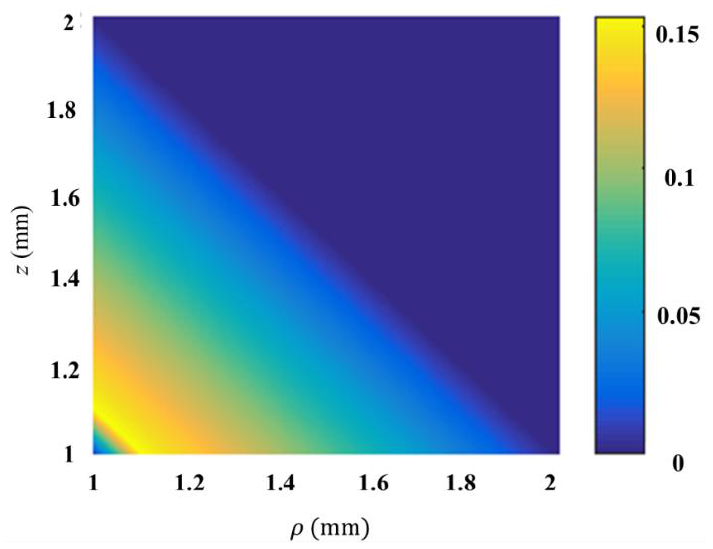
Figure 7. Front view of the enrichment function diagram of chosen element E based on Figure 6. Top view of the enrichment function diagram of chosen element E based on triangular triangular elements. elements.